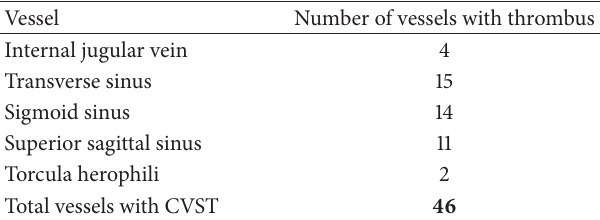
Table 2: Distribution of